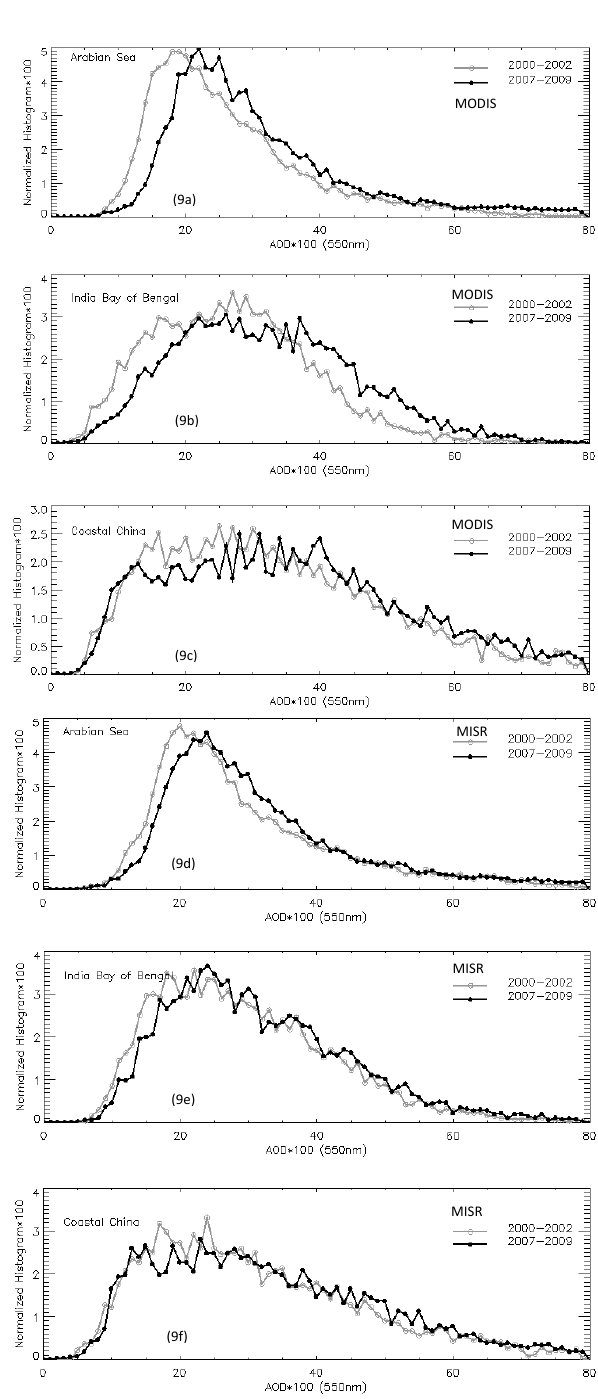
Fig. 9. (a) Normalized AOD histogram for 2000–2002 and 2007– 2009 periods over the Arabian Sea. The 6-h, 1 × 1 ◦ (Lat/Lon) DA quality MODIS aerosol product was used. (b) Similar to (a) but for Indian Bay of Bengal. (c) Similar to (a) but for Coastal China. (d–f) Similar to a–c, but for